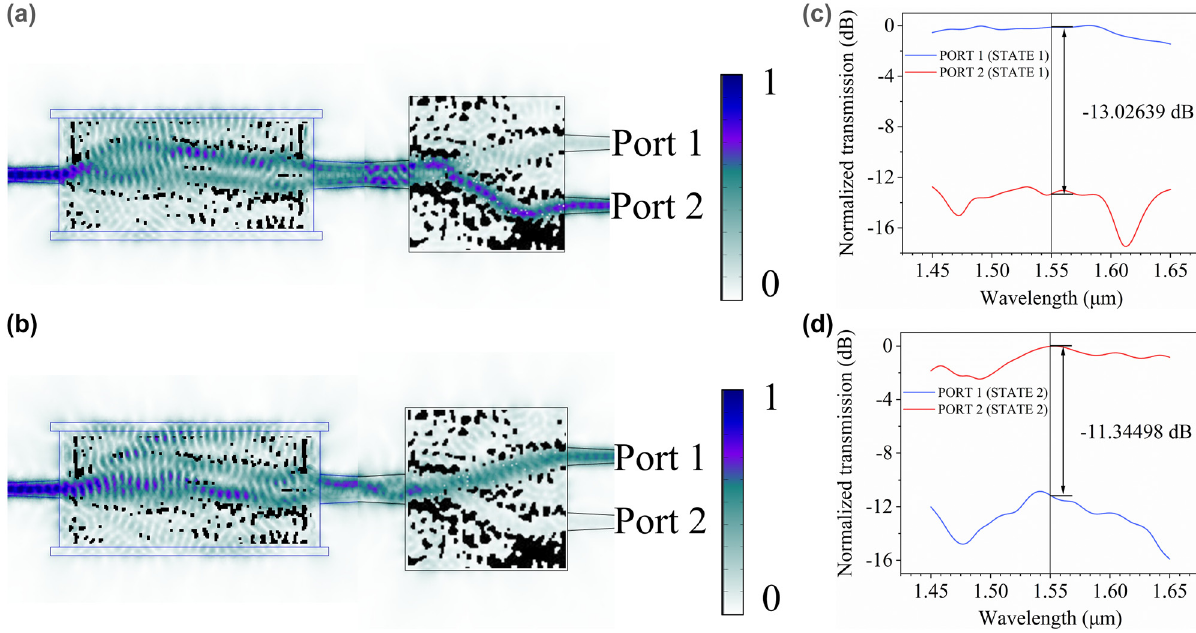
Figure 4: Simulation results at different states. (a) and (b) The light intensity distribution of TMC and mode demultiplexer filled with H respectively. (c) and (d) The simulated spectral responses of normalization transmission for input TE